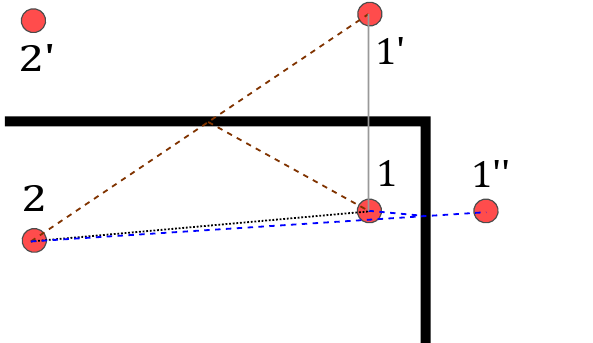
Figure 3. Visualization of multipath components and the position of virtual